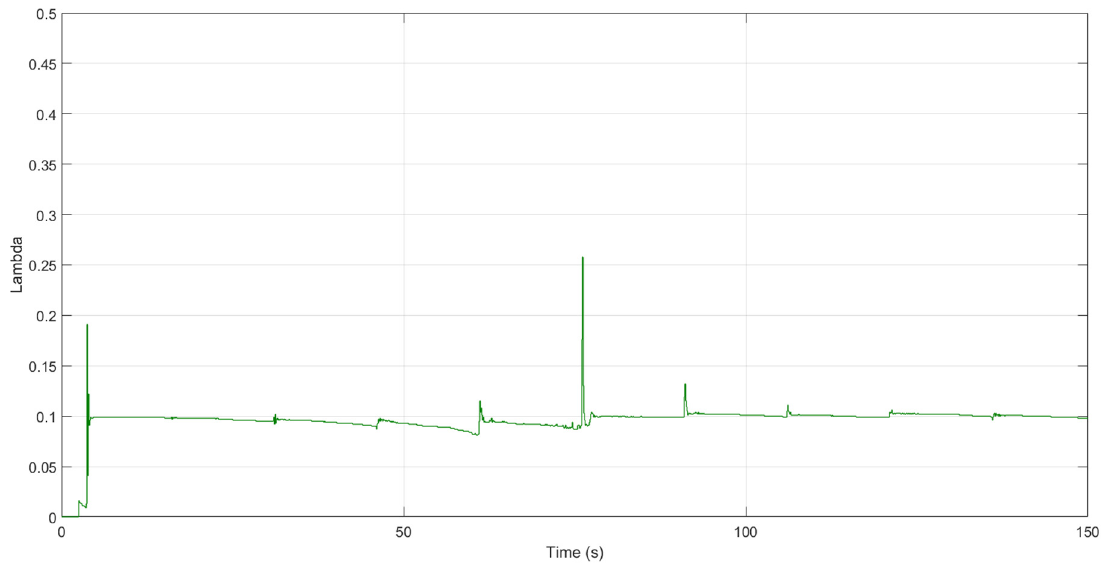
Figure 7. Rate ‐ of ‐ change of applied controls (process input) in the unconstrained case.